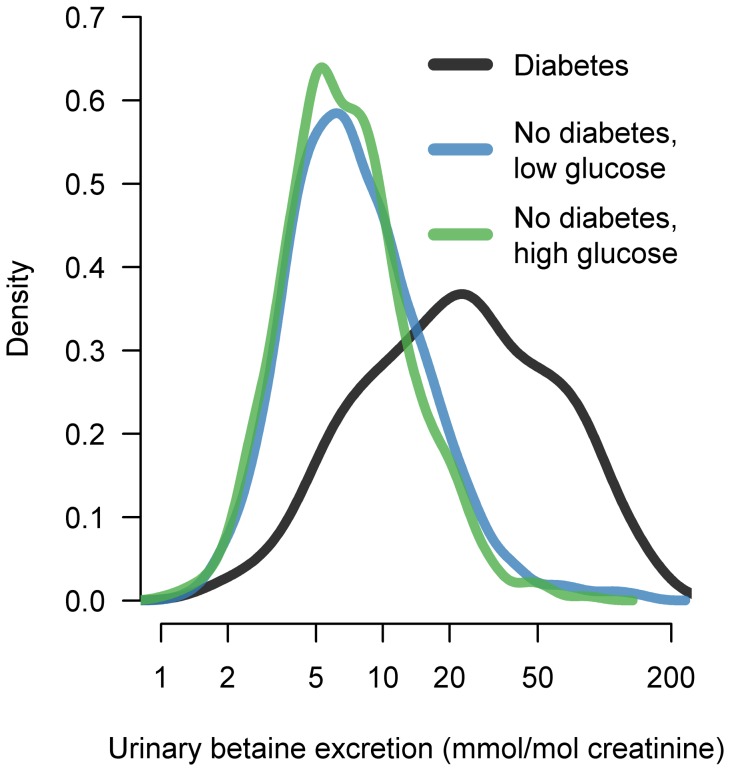
Density plot showing the relative distributions of urinary betaine excretion in patients with diabetes (black line), no diabetes and serum glucose ≥5.5 mmol/L (green line), and no diabetes and serum glucose <5.5 mmol/L (blue line).